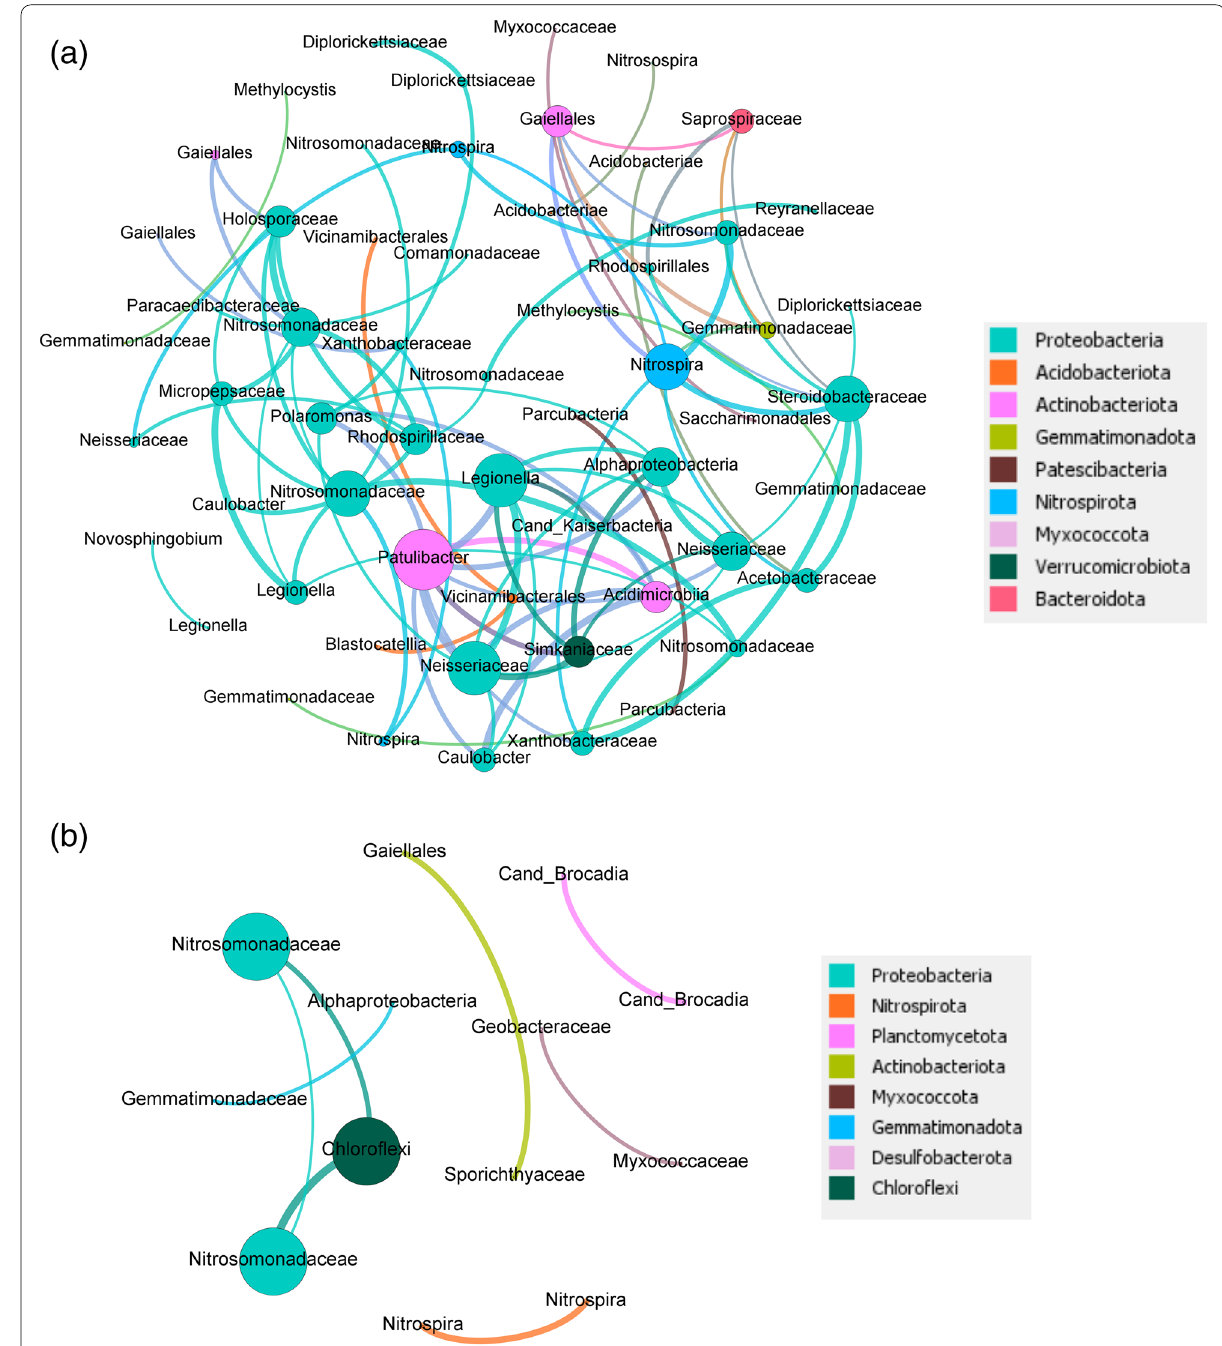
Fig. 5 Co-occurrence network in the intermediate ( a ) and distal ( b ) wells. Each connection represents a strong positive and significant Spearman’s correlation (ρ > 0.6, P < 0.01) and the thickness of the connections is proportional to the correlation coefficient. The size of the nodes is proportional to the node degree (number of connections), and the node colours represent microbial